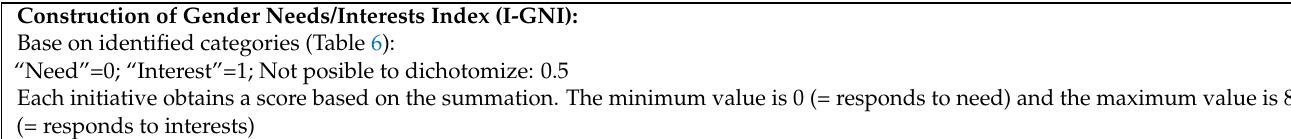
Table 7. Construction of Gender Needs/Interests Index